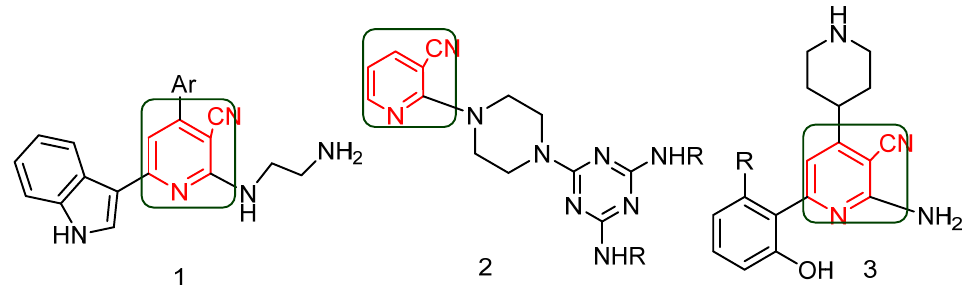
Figure 1. Nicotinonitriles with anti-proliferative, anti-Alzheimer’s anti-inflammatory activities.